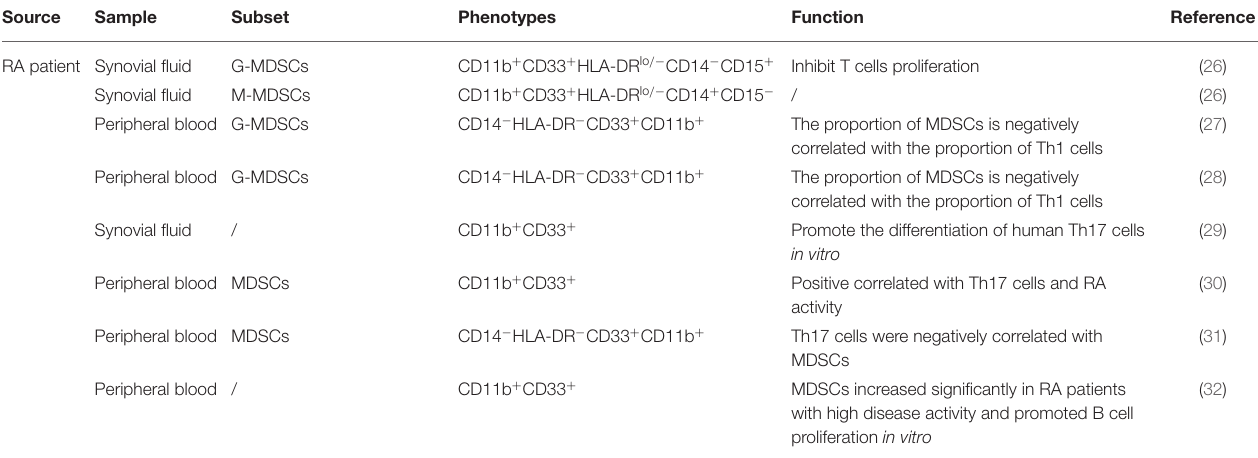
TABLE 1 | Subpopulations and phenotypes of MDSCs in RA patients.